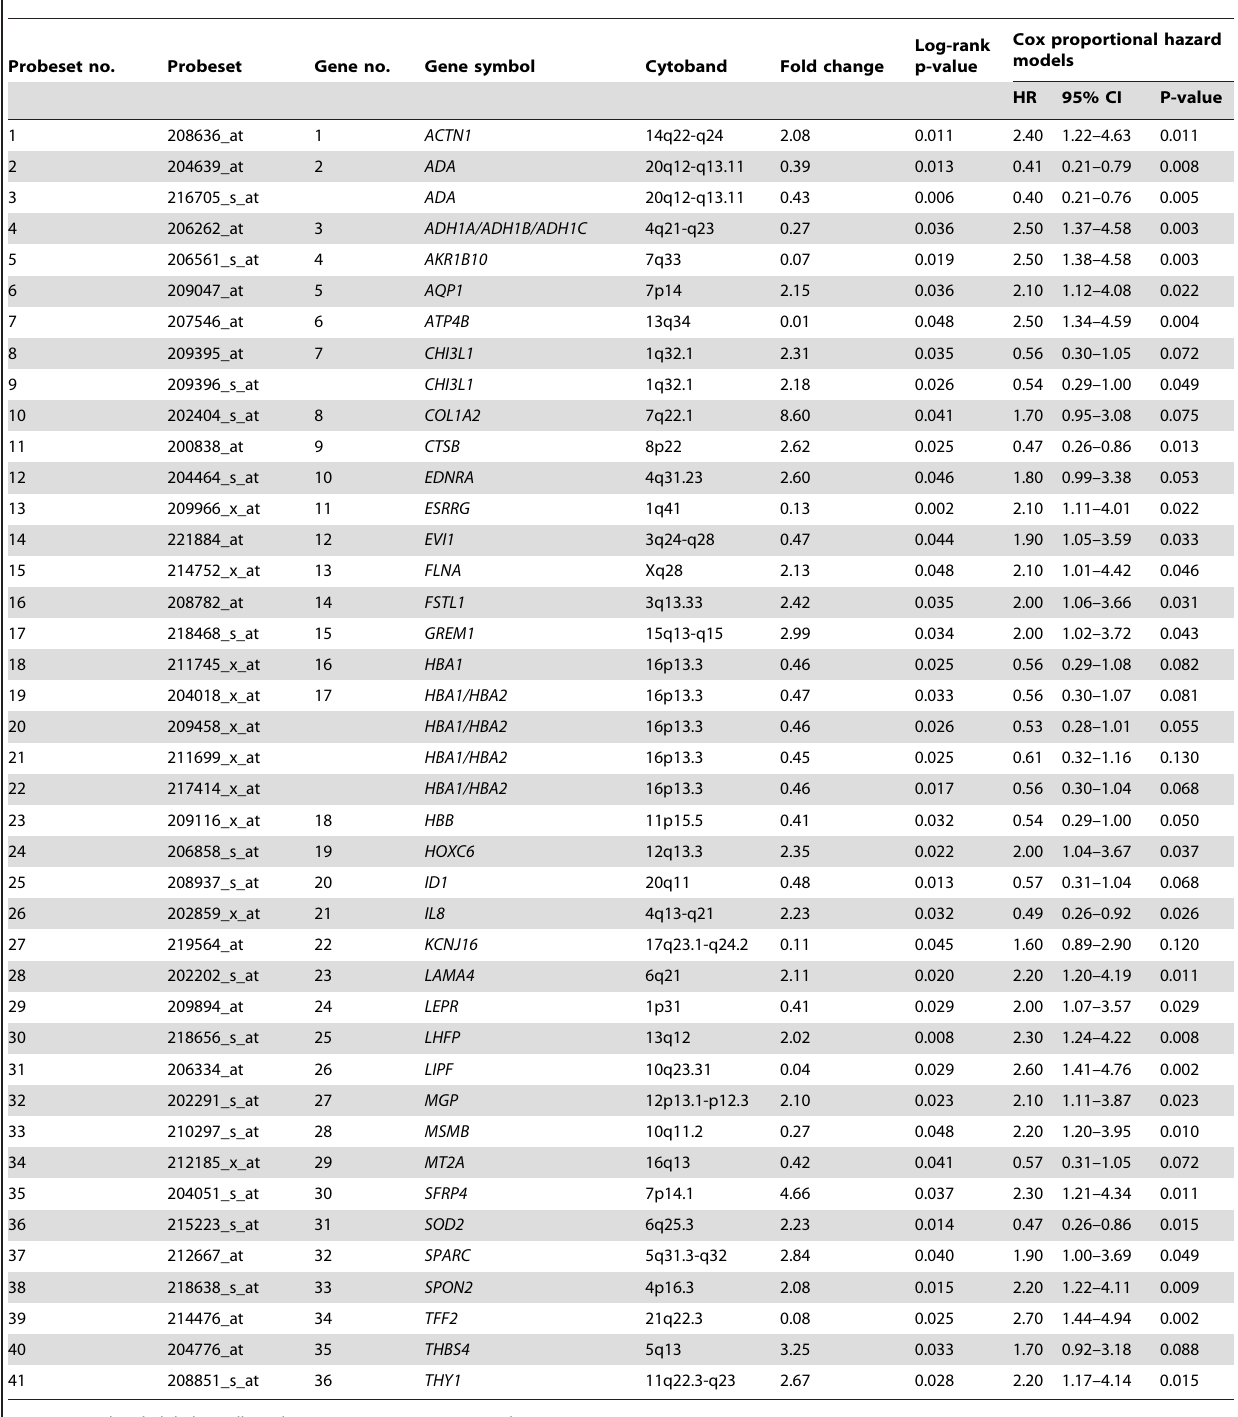
Table 3. Genes whose expression was significantly associated with survival in gastric noncardia adenocarcinoma cancers (log-rank p-value , 0.05; n